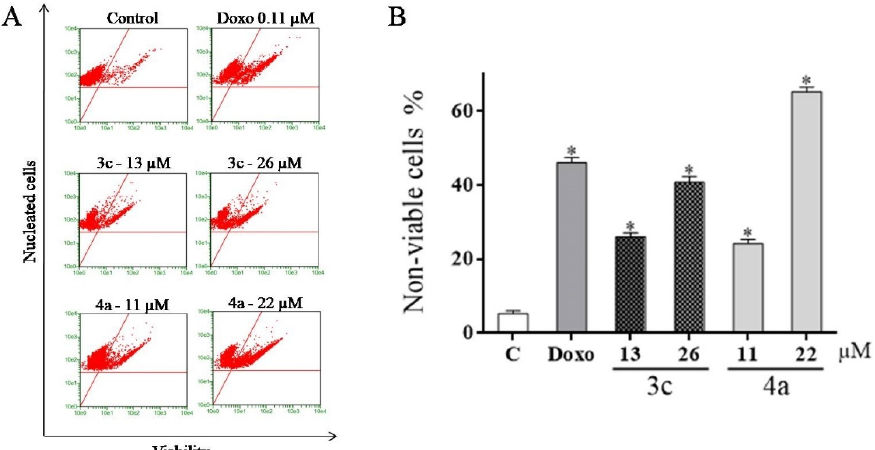
Figure 4. Effect of compounds 3c and 4a on cell viability of HL ‐ 60 cells using the ViaCount kit after 72 h of incubation. ( A ) Dot plots, where viable cells are located in the upper left quadrant, and non ‐ cells in the upper right quadrant; ( B ) The percentage of non-viable cells was shown as the mean ± viable cells in the upper right quadrant; ( B ) The percentage of non ‐ viable cells was shown as the mean ± SD from three independent experiments performed in triplicate. * p < 0.05 compared with the negative control by ANOVA followed by Student Newman ‐ Keuls test. C = control; Doxorubicin (Doxo, 0.11 μ M) was used as a standard drug. The negative control was treated with the vehicle (DMSO; 0.1%).